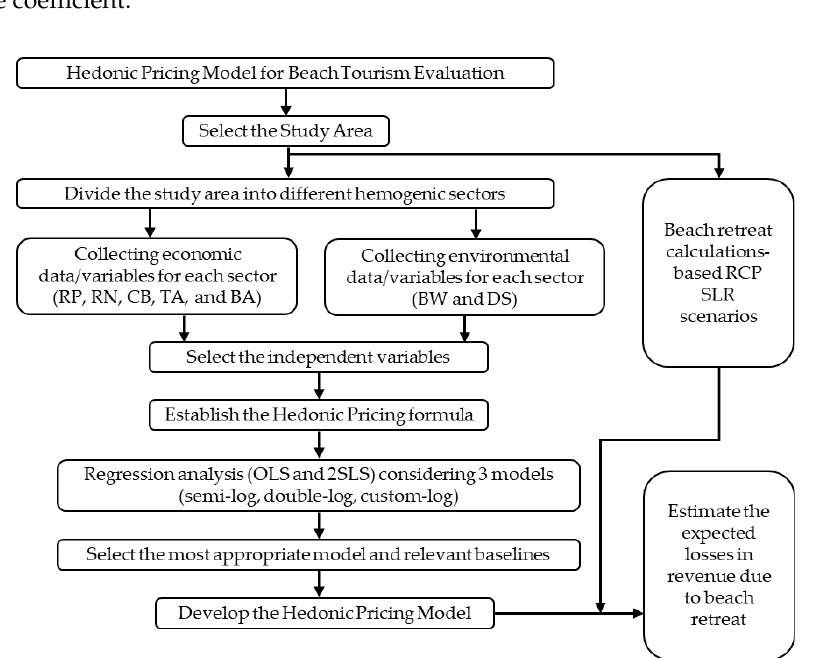
Figure 2. Methodological framework for developing a hedonic pricing formula.